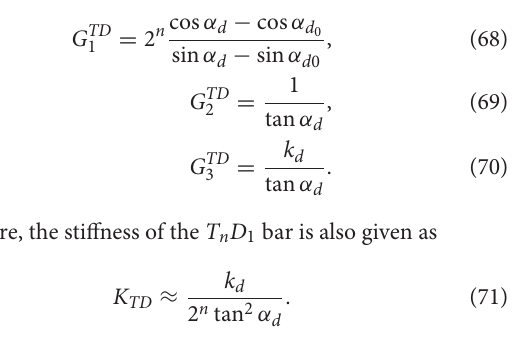
of F 1000 N . The materials are selected as given in Table 1 . =